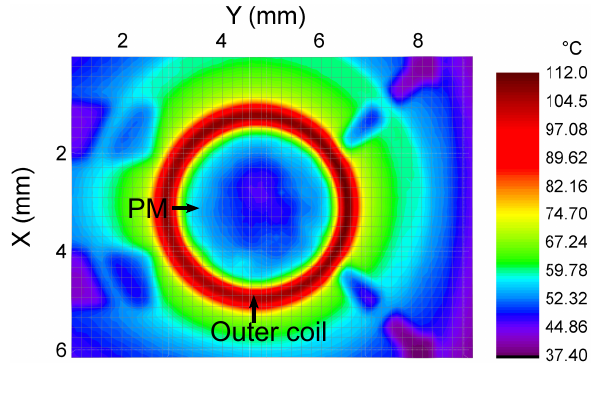
Figure 10. Temperature distribution of the 3D MIS and a 3200 µm-diameter Al PM (blue in the center) after the MIS reached thermal equilibrium. The inner coil is blocked by the PM. IR camera resolution: 0 . 1